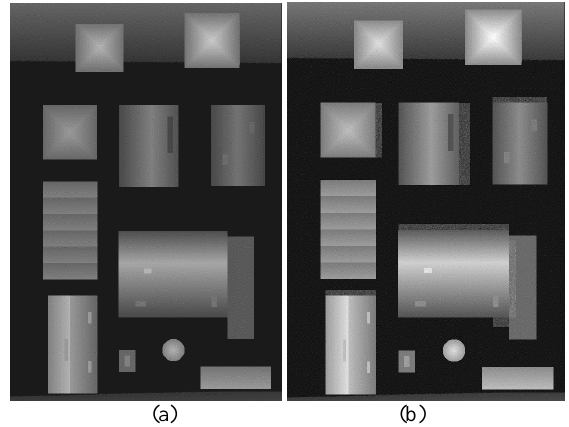
Figure 2: ground truth (a) and noisy DSM (b).